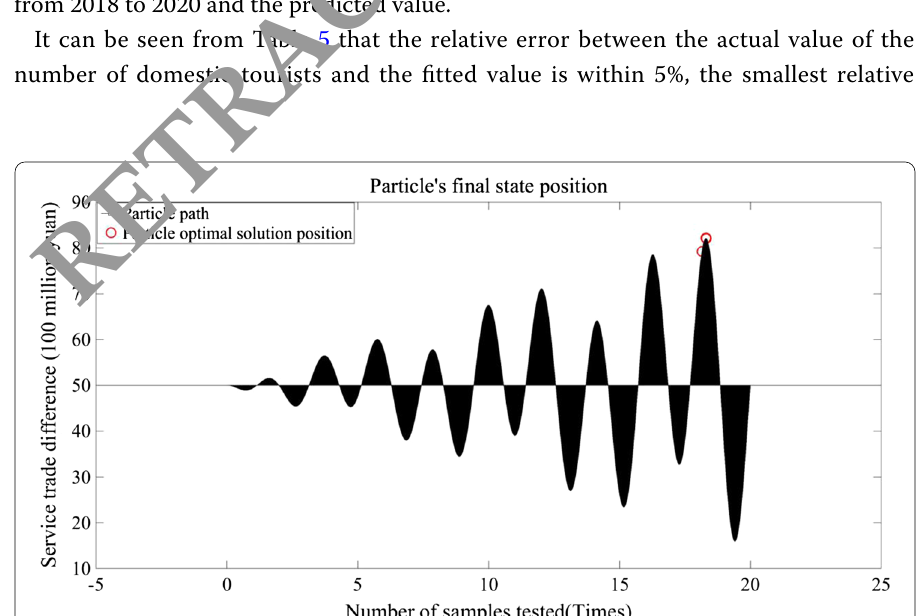
Fig. 4 The situation of the final optimal